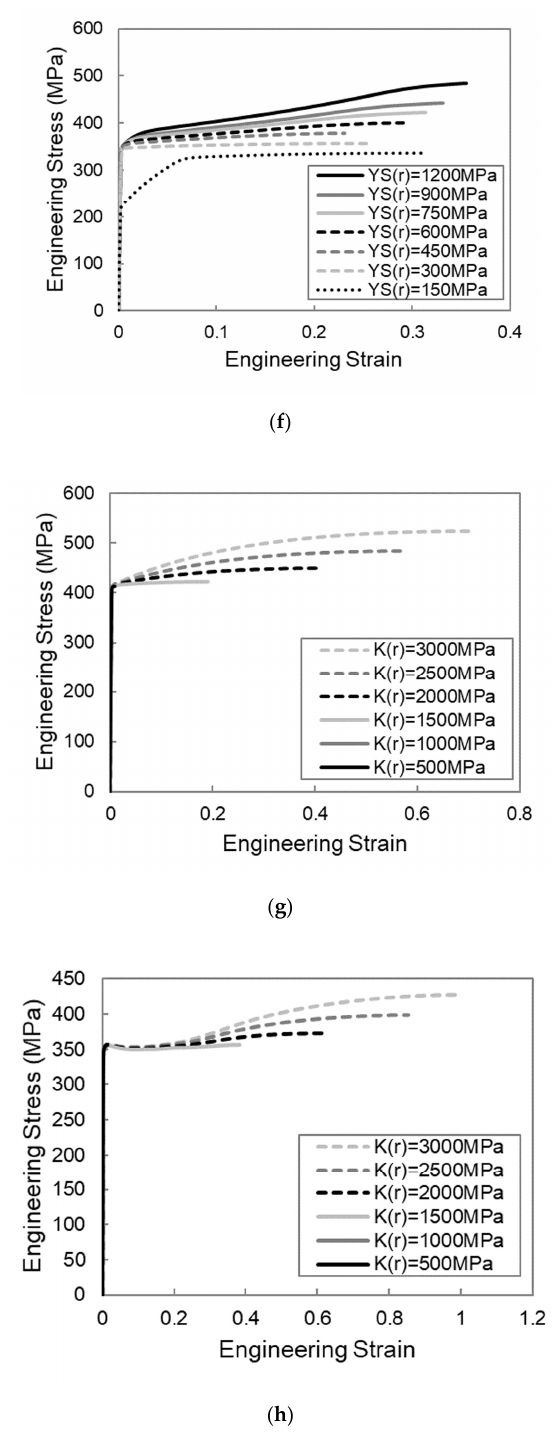
Figure 2. E ff ect of material properties on the stress–strain curves obtained using FEM simulations of straight and corrugation reinforced composites. The following material properties were varied: ( a ) matrix yield strength, YS(m), for a composite with a straight reinforcement; ( b ) matrix yield strength, YS(m), for a composite with a corrugated reinforcement; ( c ) matrix hardening rate, K(m), for a composite with a straight reinforcement; ( d ) matrix hardening rate, K(m), for a composite with a corrugated reinforcement; ( e ) reinforcement yield strength, YS(r), for a composite with a straight reinforcement; ( f ) reinforcement yield strength, YS(r), for a composite with corrugated reinforcement; ( g ) reinforcement hardening rate, K(r), for a composite with straight reinforcement and ( h ) reinforcement hardening rate, K(r), for a composite with corrugated